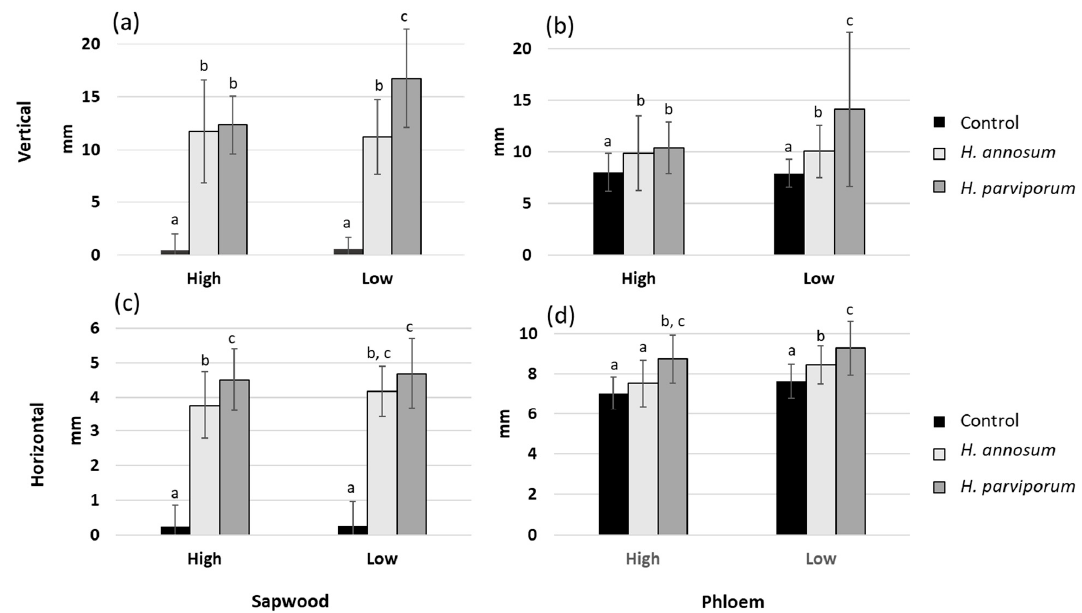
Figure 4. Length of necrosis (mm) observed after inoculation experiment with mock-inoculated control, H . annosum and H . parviporum in Norway spruce saplings in different water availability groups. Averages of vertical ( a , b ) and horizontal ( c , d ) length (mm) of necrosis in sapwood ( a , c ) and phloem ( b , c ) measured to the nearest 0.001 mm.